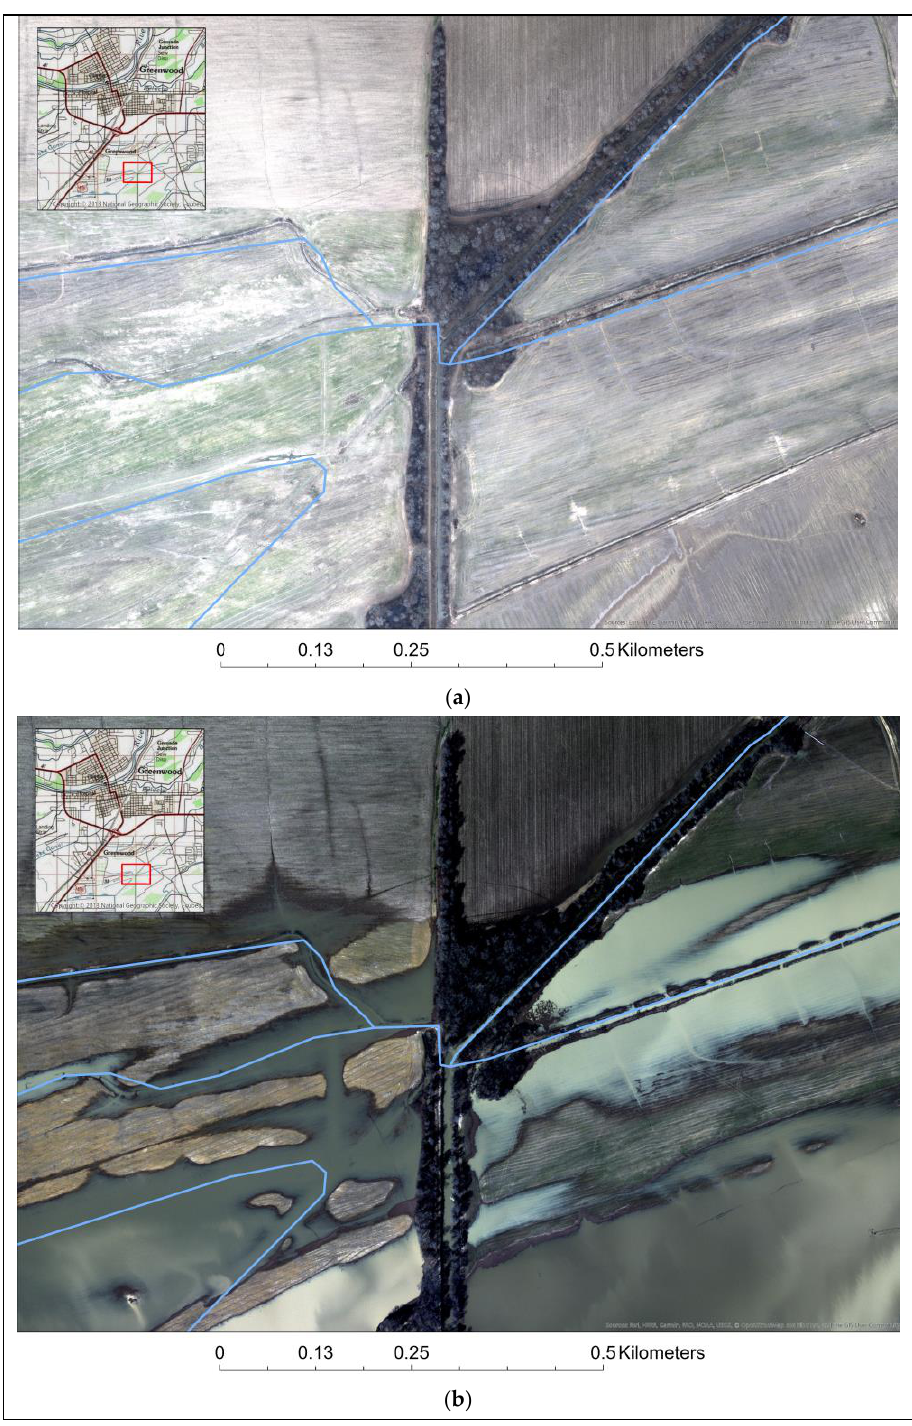
Figure 4. UAS-collected Red-Green-Blue (RGB) imagery showing ( a ) low flow conditions on Jan. 16, 2019 and ( b ) flood conditions on Feb. 24, 2019 over an agricultural area south of Greenwood, MS. Blue lines denote water flowlines defined by the National Hydrography Dataset.